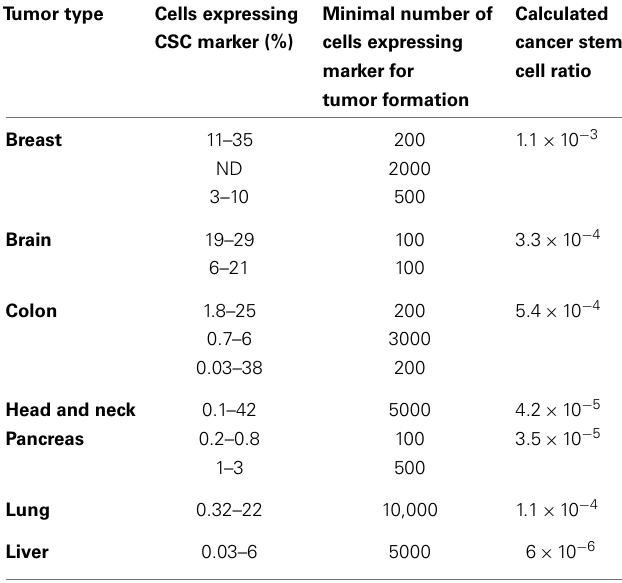
Table 1 | Cancer stem cells in solid